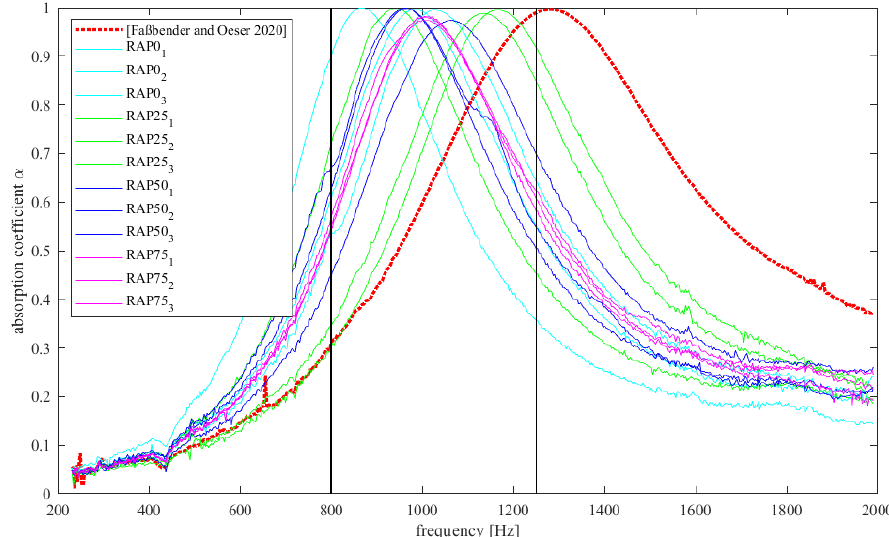
Figure 4. Absorption coefficient curves of the variants RAP0, RAP 25, RAP 50, RAP 75 and from Ref.